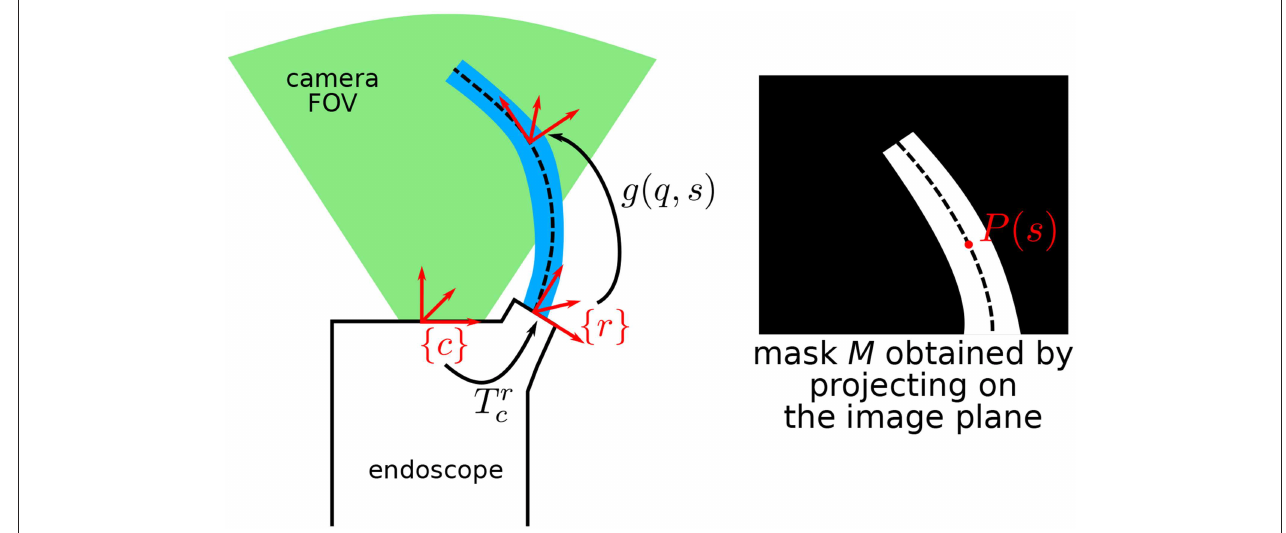
FIGURE 3 | Schematic describing the general situation, where a continuum robot is in the field of view (FOV) of an endoscopic camera. P ( s ) is the projection of the centerline of the robot at arc-length s onto the image